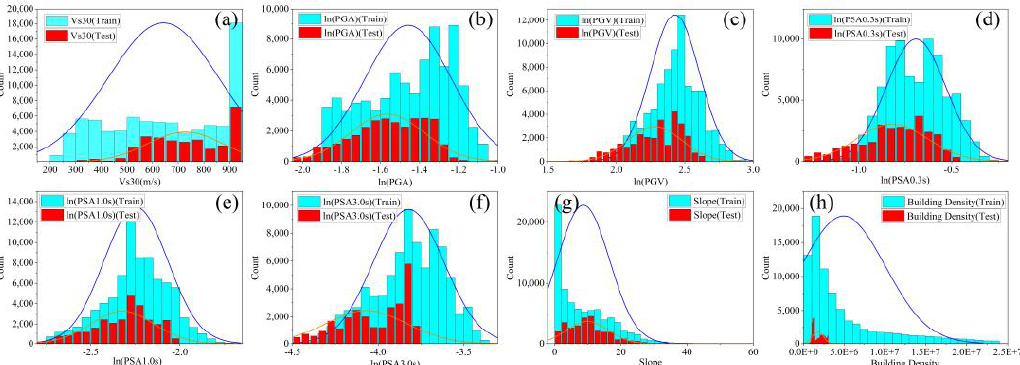
Figure 12. Ranges of influencing factors of Nepal earthquake. Subplots ( a – h ) represent the value distribution of Vs30, PGA, PGV, PSA0.3s, PSA1.0s, PSA3.0s, slope, building density, and other factors. The blue histogram and curve represent the distribution of values on the training set, and the red histogram and curve represent the distribution of values on the test set.